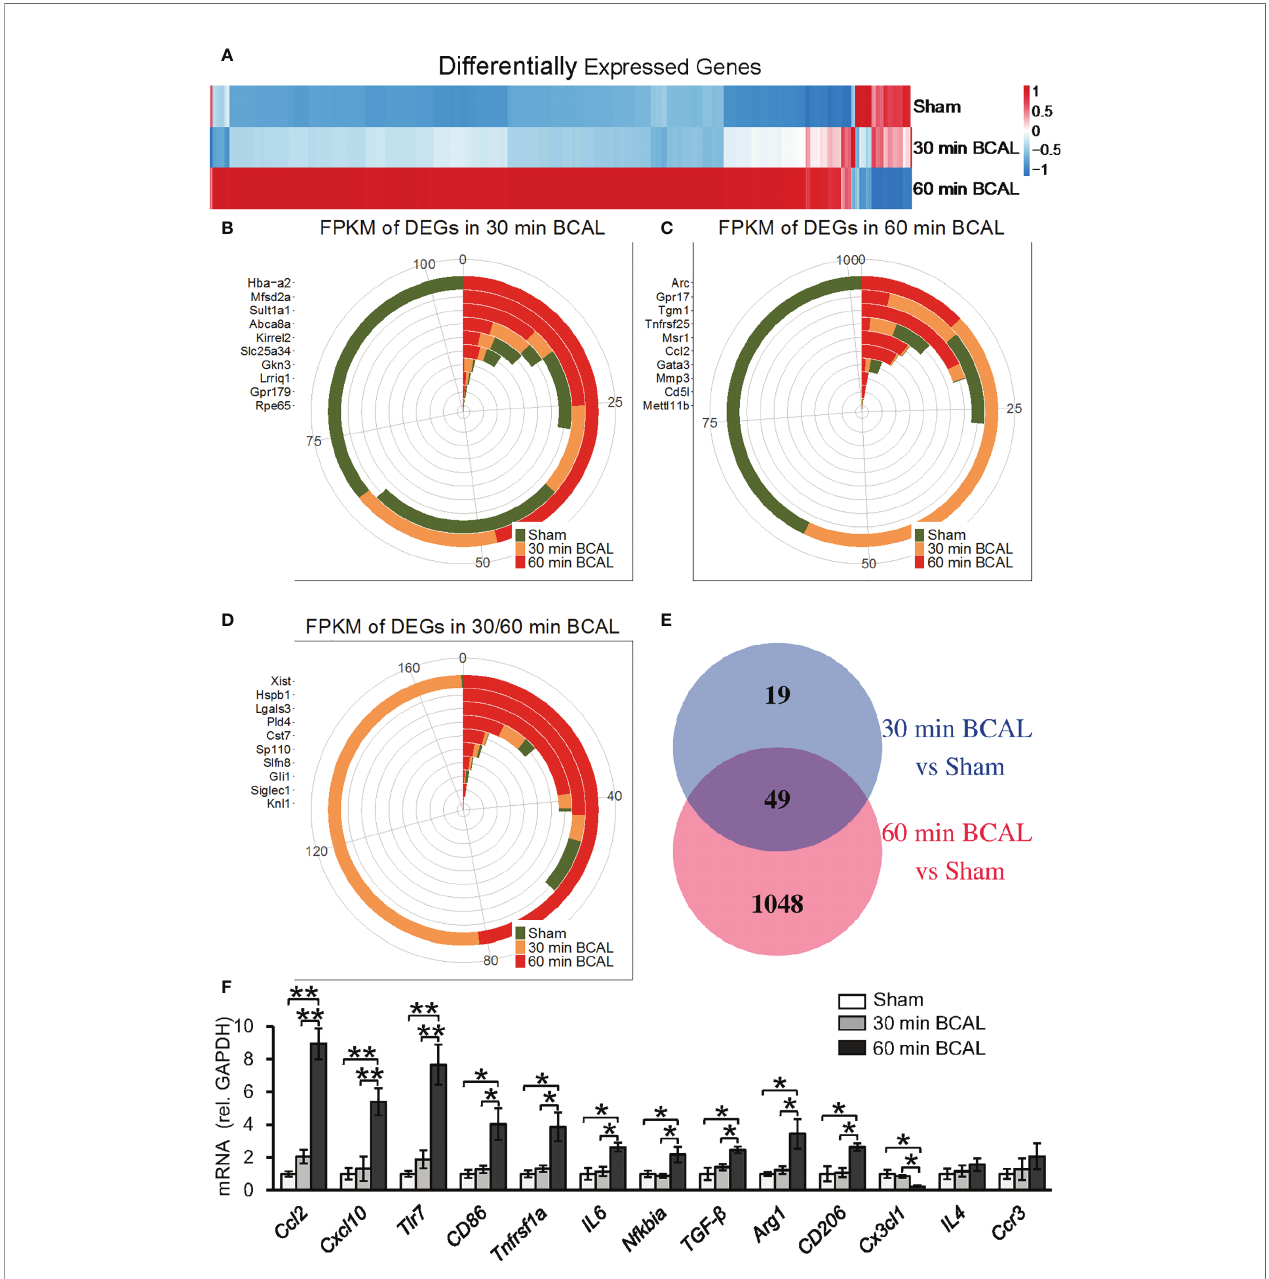
FIGURE 3 | Differentially expressed genes after ischemic stroke. (A) Heatmap showing the gene expression between different groups. Genes with similar expression pattern were clustered. Colors show the relative up- and downregulation of each gene. (B – D) Top 10 genes with the largest Fold Change in 30 min BCAL group, 60 min BCAL group, and both groups. The expression of the gene is presented as Fragments Per Kilobase of transcript per Million mapped reads (FPKM). (E) Venn diagram showing the number of DEGs in each group. The overlapping region indicates the number of genes that were expressed in both 30 min BCAL and 60 min BCAL group. (F) The validation of DEGs using qRT-PCR. The mRNA expression level of each gene was normalized to GAPDH (n = 4 mice for each group; * p <0.05, ** p <0.01). Multiple genes that related to microglial activation were differentially expressed in 60 min BCAL. These data are consistent with DEG